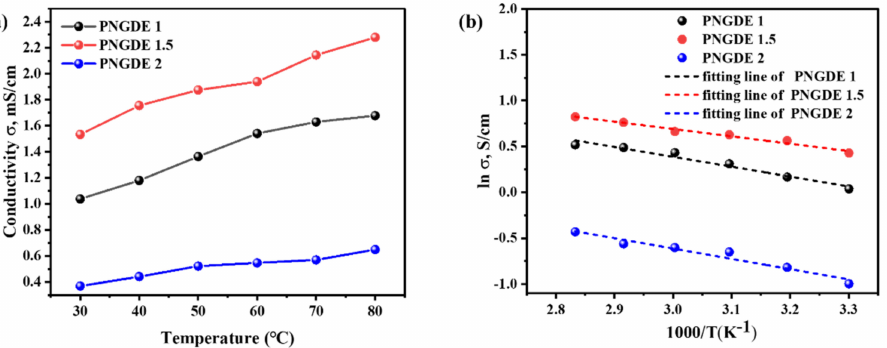
Figure 4. ( a ) Ionic conductivity versus temperature plots of PNGDEs and ( b ) Arrhenius plots of corresponding